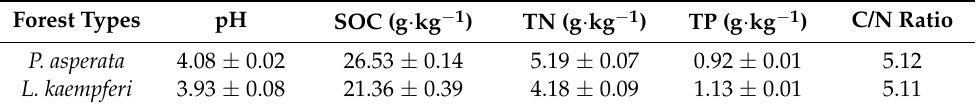
soils of P. asperata forest (0.92 ± 0.01 g · kg − 1 ) (Table 3). Table 3. Physicochemical properties of sampling soils. Table 3. Physicochemical properties of sampling soils. Forest Forest Types